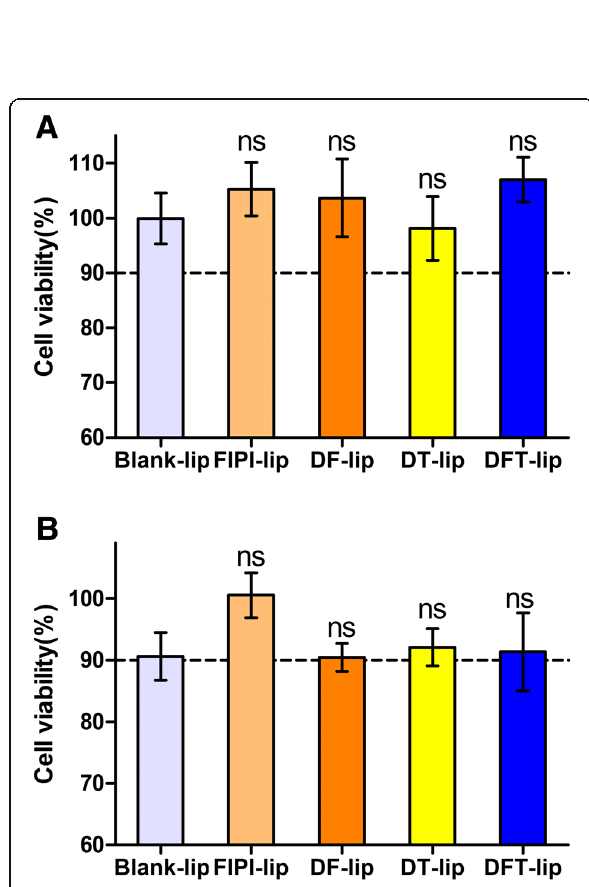
Fig 5 Cell viability of MDA-MB-231 cells incubated with Blank-lip, FIPI-lip, DF-lip, DT-lip, and DFT-lip for 7 h ( a ) or 24 h ( b ) at a concentration of 2 μ M FIPI, respectively. All the data presented here were calculated as mean ± SD ( n = 6). Notes: ns, p > 0.05 versus blank